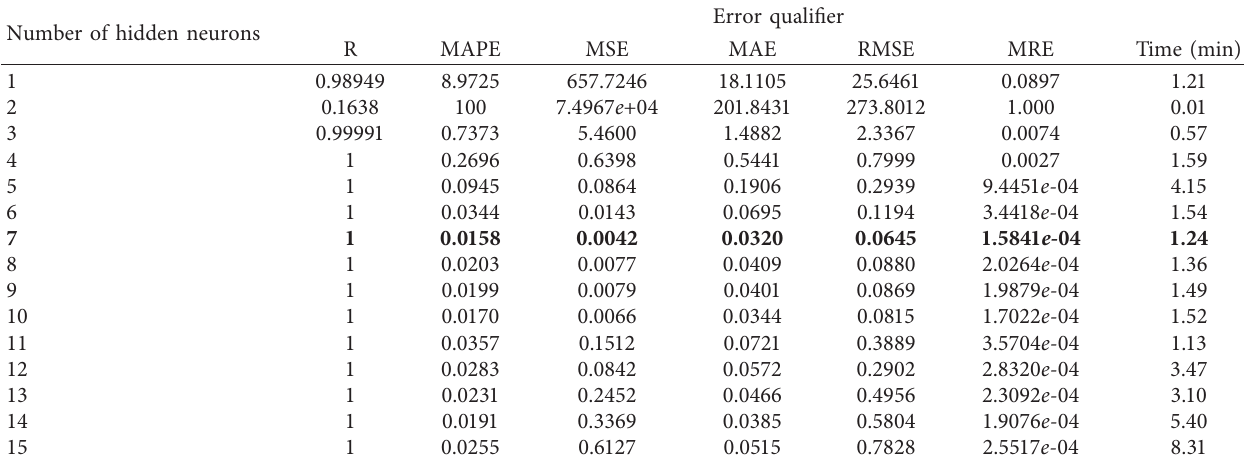
Bold implies the best results. Table 5: The proposed five inputs based on improved backpropagation neural network statistical performance analysis with various hidden neurons for rainfall